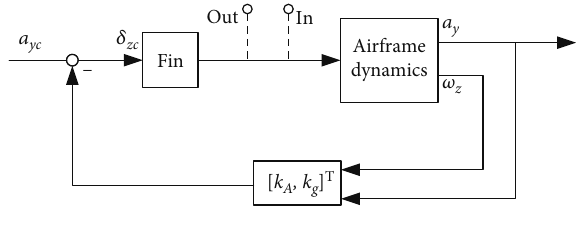
Figure 2: Two-loop autopilot structure.